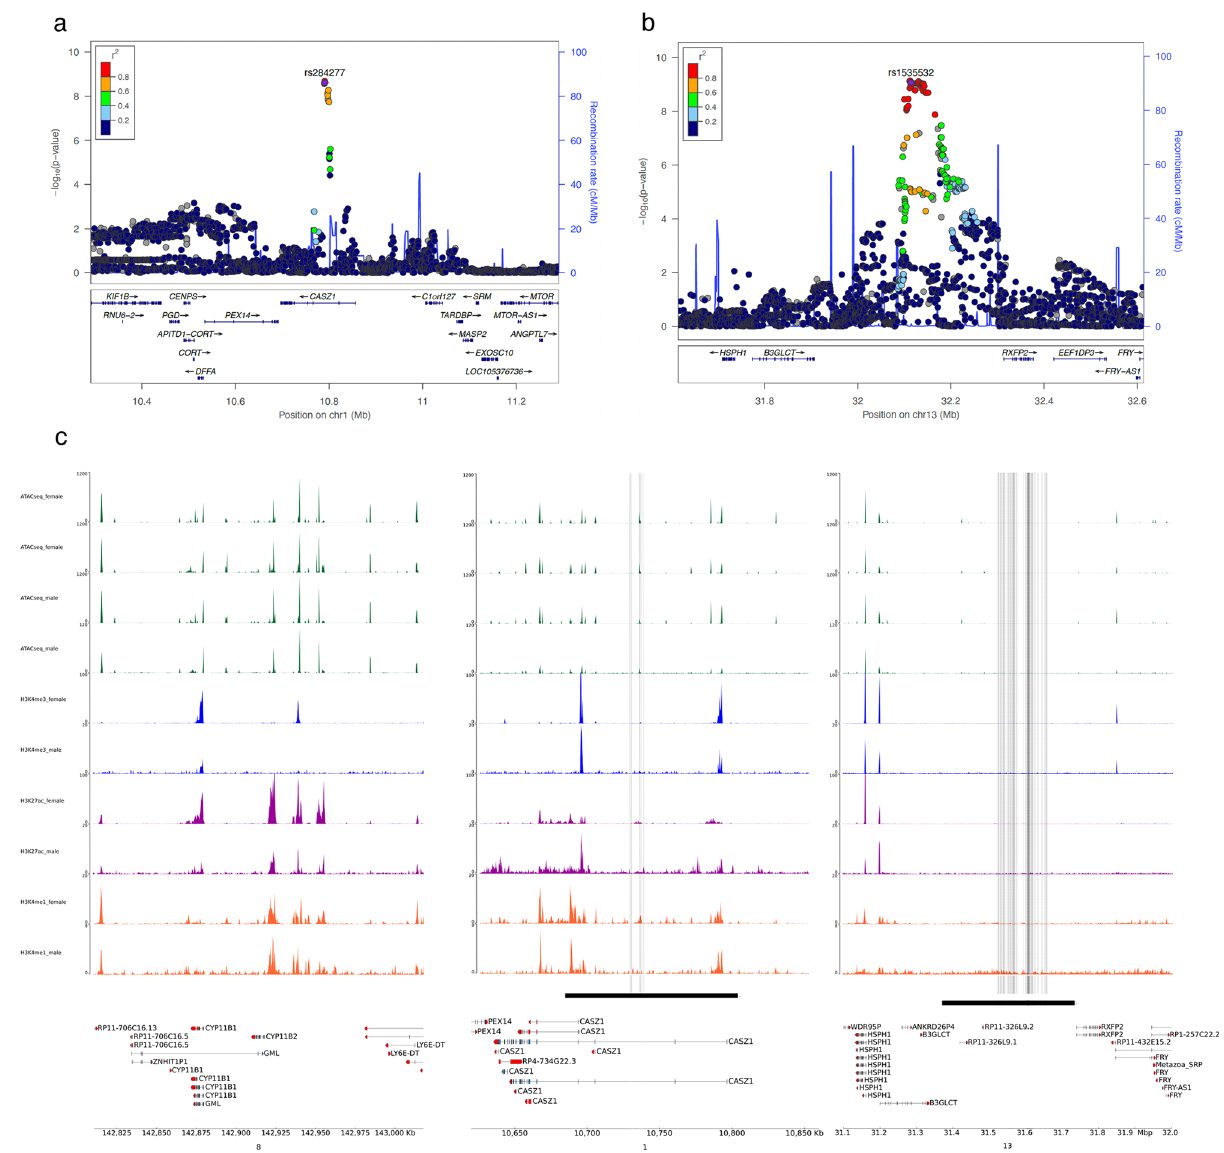
Fig.2|GenomiccontextoftheassociationsignalsobservedintheGWASinthe discoverycohort. TheregionalassociationplotsweregeneratedusingLocusZoom on imputed data and display surrounding genes (genome build 37). The two dif- ferent loci on chromosome 1 ( a ) and chromosome 13 ( b ) con fi rmed in the meta- analysisarerepresented;dot color indicates linkage disequilibrium ofeach variant with the highlighted lead variant in common between discovery and replication cohorts (purple diamond). c Genome browser view of public ATAC-seq and ChIP- seq signals produced by the ENCODE consortium from adrenal gland tissue on chromosome 8 (region 142,810,559 – 143,017,843, hg38 build), chromosome 1